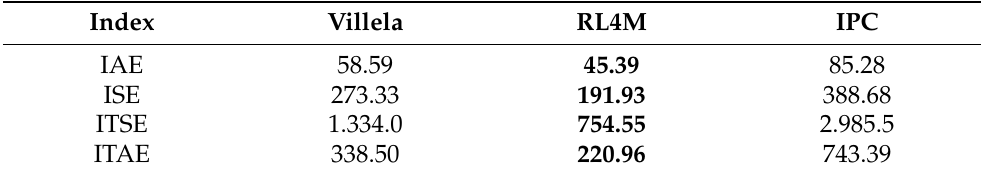
Table 2. Performance indexes for each algorithm in the position control experiment. In bold, the bet- ter